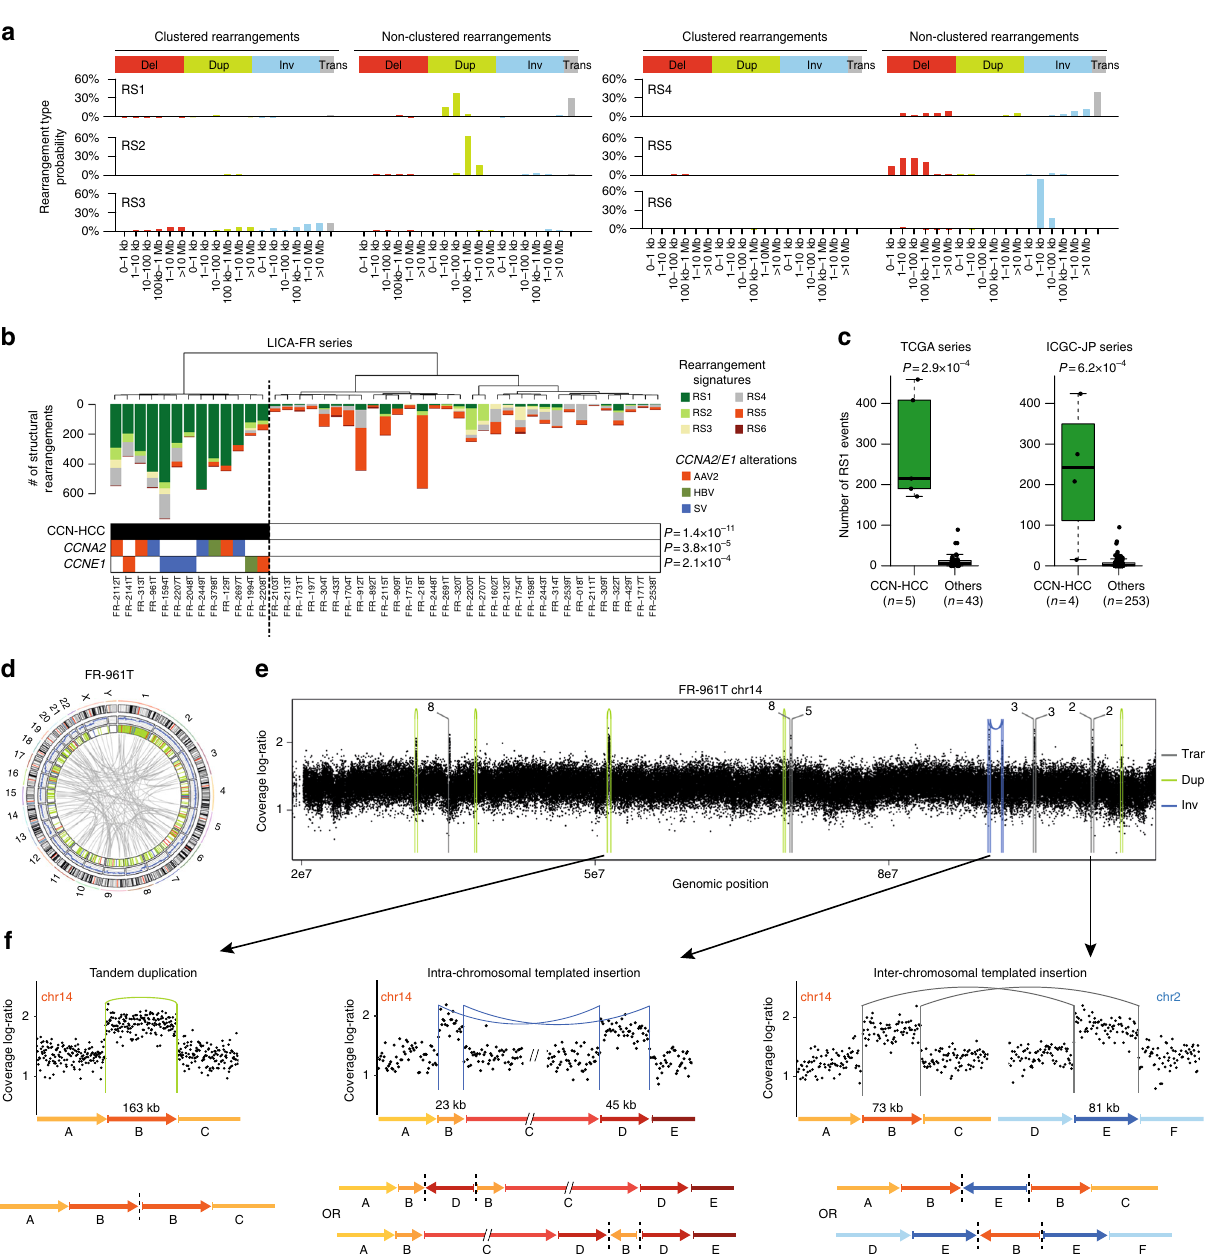
Fig. 4 Cyclin-activated HCC display a speci fi c signature or structural rearrangements. a Six rearrangement signatures identi fi ed across 350 HCC genomes by non-negative matrix factorization. Structural rearrangements were classi fi ed in 38 categories considering their type (del: deletion, dup: tandem duplication, inv: inversion, trans: inter-chromosomal translocation) and size, and distinguishing clustered from non-clustered events. The probability of each rearrangement category in each signature is represented, with rearrangement types indicated above and rearrangement sizes below. b Unsupervised classi fi cation of 45 HCC from the LICA-FR cohort based on the contribution of rearrangement signatures in each tumor. Signi fi cant molecular alterations associated with the cluster of tumors having a high contribution of signature RS1 are represented below. P -values were obtained using Fisher ’ s exact tests. c Validation of the association between the RS1 signature and CCN-HCC in the TCGA and ICGC-JP series. The middle bar, median; box, interquartile range; bars extend to 1.5 times the interquartile range. d CIRCOS plot representing the structural rearrangement pro fi le of a representative CCN-HCC (FR-961T, harboring a GSTCD - CCNA2 fusion). e Copy-number pro fi le showing the accumulation of focal gains along chromosome 14 in tumor FR-961T. Structural rearrangements are overlaid on the copy-number pro fi le with a color code indicating the type of event. trans: inter-chromosomal translocation; dup: tandem duplication; inv: inversion. f Three types of rearrangements leading to focal chromosome gains in CCN-HCC. A representative example of each type of event is shown with a copy-number plot above and a schematic representation of the rearranged chromosome below. Structural rearrangements are represented with the same color code as in e . Dashed lines on schematic chromosome reconstructions represent the abnormal junctions detected in WGS